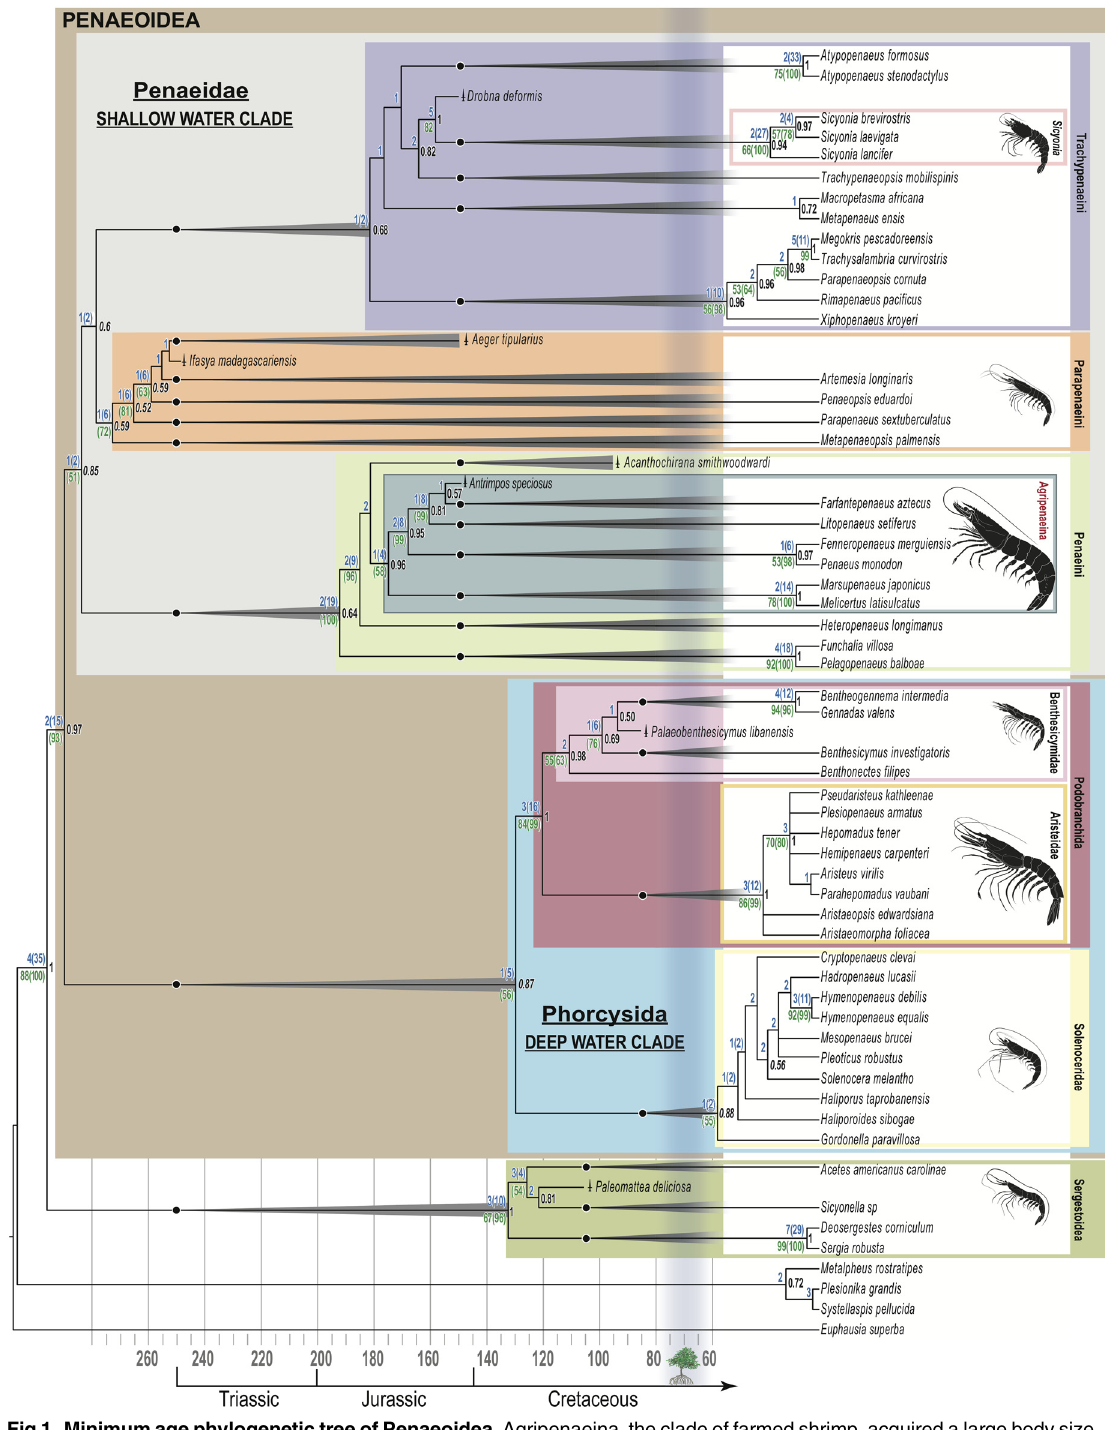
Fig 1. Minimum age phylogenetic tree of Penaeoidea. Agripenaeina, the clade of farmed shrimp, acquired a large body size despite the physiological constraints of their warm and shallow-water habitats. This clade is at least 145 my old because it includes a Late Jurassic species ( † Antrimpos speciosus ) that inhabited the warm waters preserved in the Late Jurassic Solnhofen limestone [14,15]. Ecological associations between shallow-water penaeoideans and mangrove forests occurred independently more than once, as clades of mangrove-associated shrimp (e.g., Agripenaeina and Trachypenaeini) predate the proposed Late Cretaceous origin of modern mangroves [16]. Shrimp silhouettes illustrate differences in maximum body size for each clade. Topology shown emerges from parsimony (strict consensus of 24 trees) and Bayesian analyses, with some